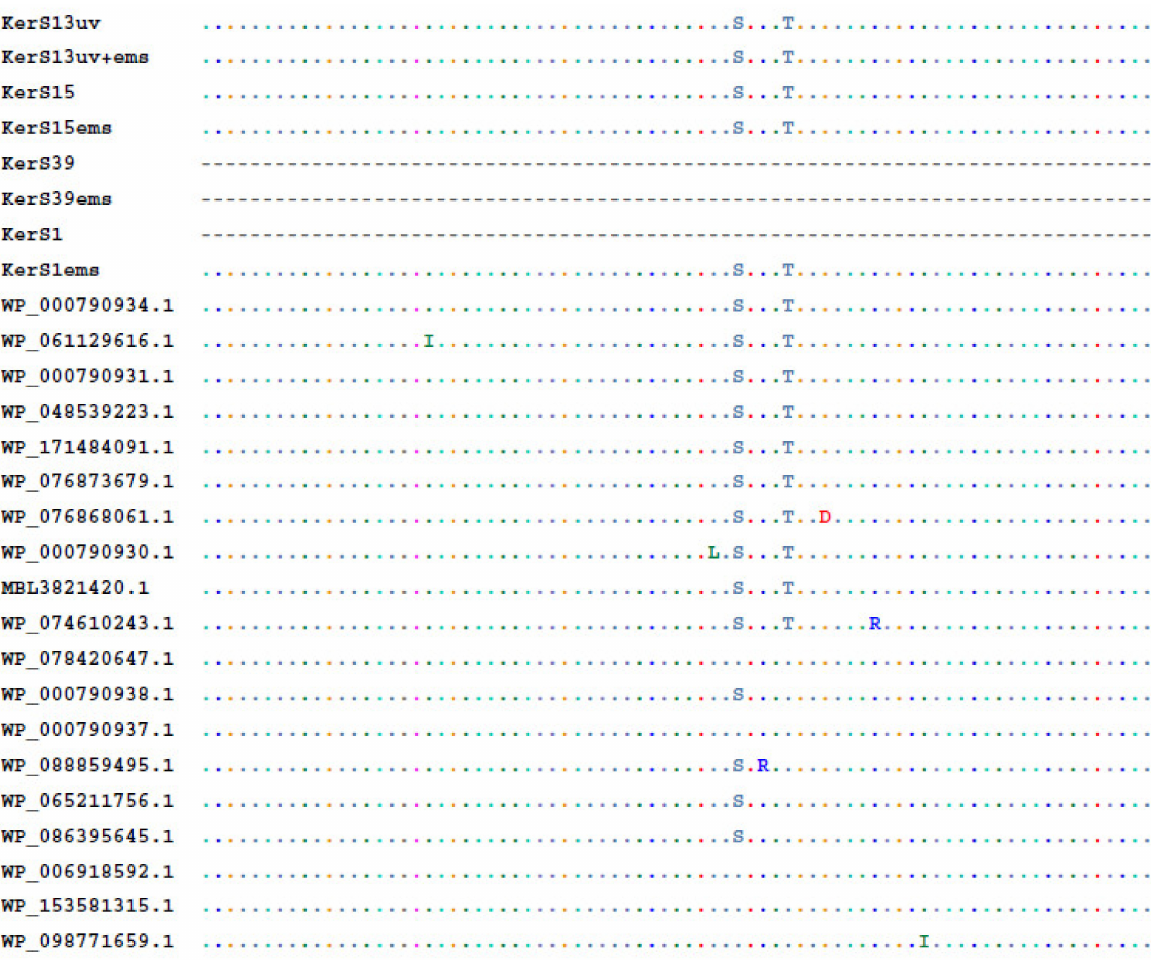
Figure 8. Multiple amino acid sequence analysis of KerS gene against S8 family peptidase Bacillus cereus group sequences retrieved from GenBank